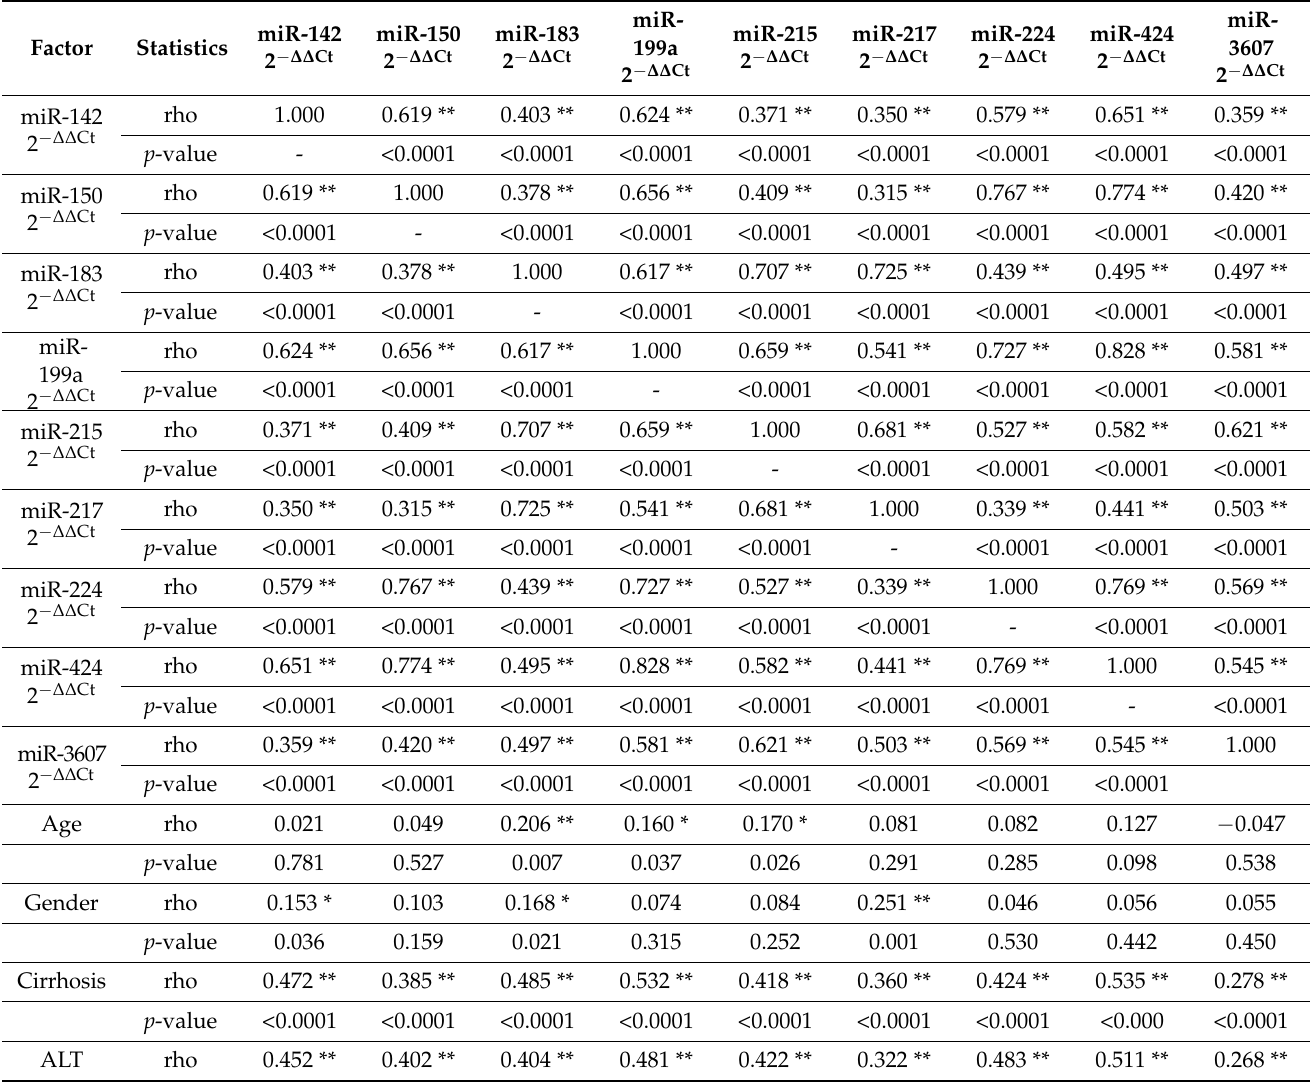
Table 6. Correlation between the target miRNAs in the study groups and other clinicopathologi- cal